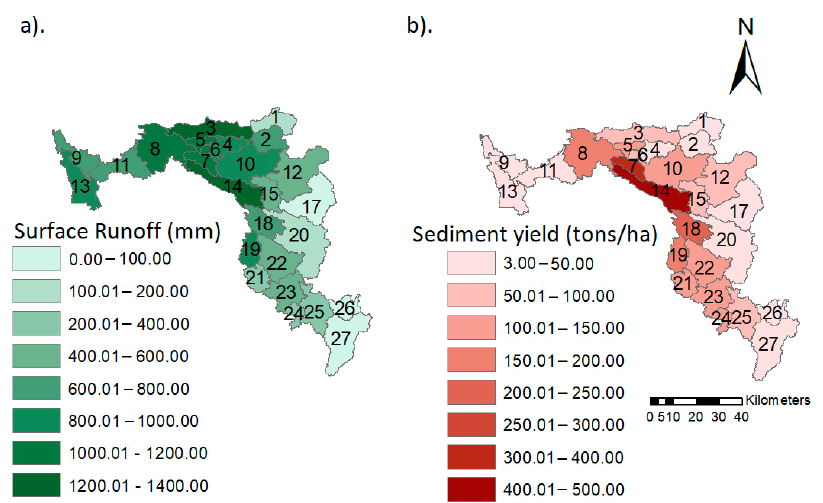
Figure 6. Spatial distribution of average annual ( a ) surface runoff and ( b ) sediment yield at sub-watershed (#1 to #27) for the period 1991–2004 with LULC 1988 (baseline). (Here, # indicates the sub-watershed ID.)